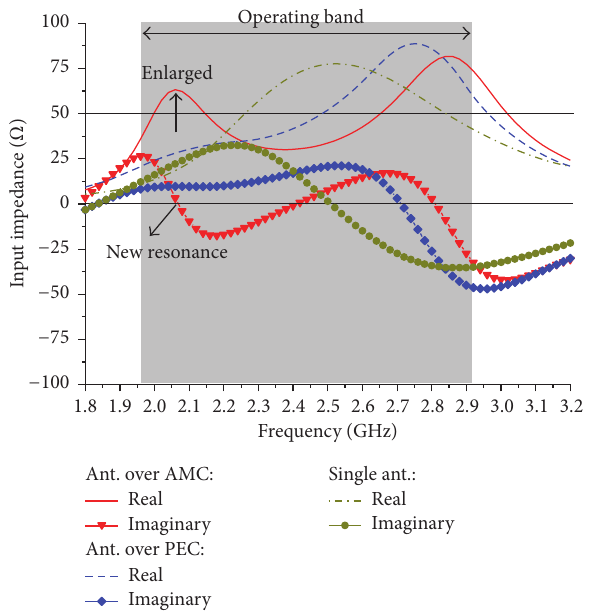
Figure4:Simulatedinputimpedanceofthedifferentdual-polarized slot antennas.